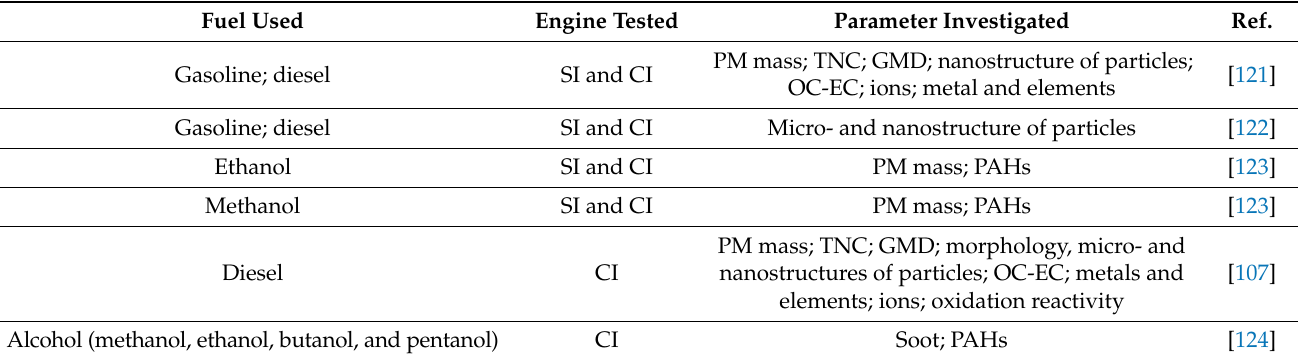
Table 4. Summary of the main parameters of the reviewed investigations available in the literature about the PM physicochemical properties of SI and CI engines.